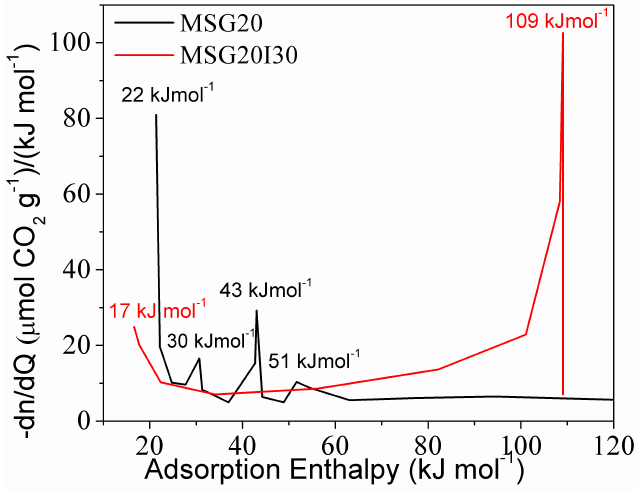
Figure 6. Energy sites distribution.